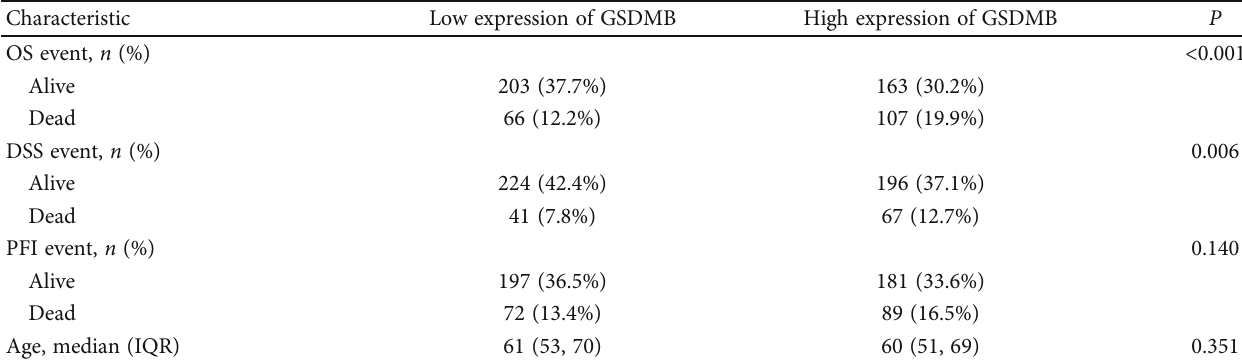
(Figure 2(b), 1 : 238 ± 0 : 585 vs. 0 : 895 ± 0 : 613 , P < 0 : 001 ), which was also validated in the GEO database (GSE53757) (Figure 2(c), 159 : 474 ± 66 : 165 vs. 107 : 306 ± 47 : 003 , P < 0 : 001 ) (Figure 2(c)). We conducted analysis on CPTAC